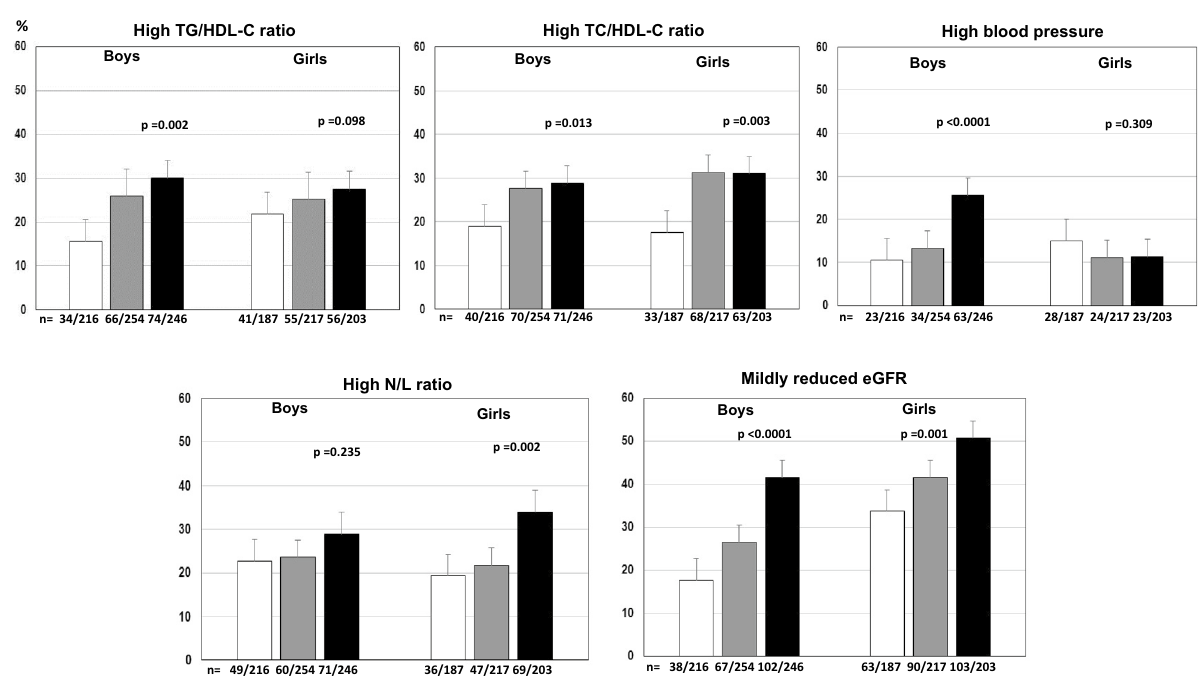
Figure 1. Proportions (mean and 95% CI) age-adjusted of youth with abnormal CMRFs across tertiles of UA both in boys and